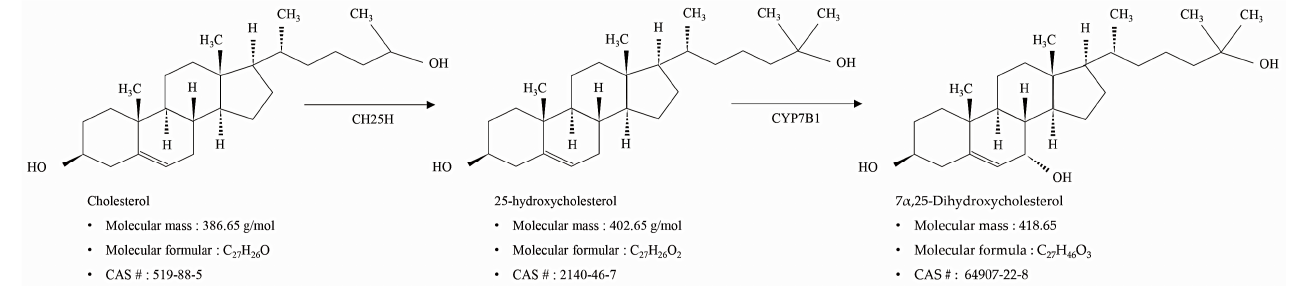
Figure 1. Synthesis and chemical information of 7 α ,25-dihydroxycholesterol (7 α